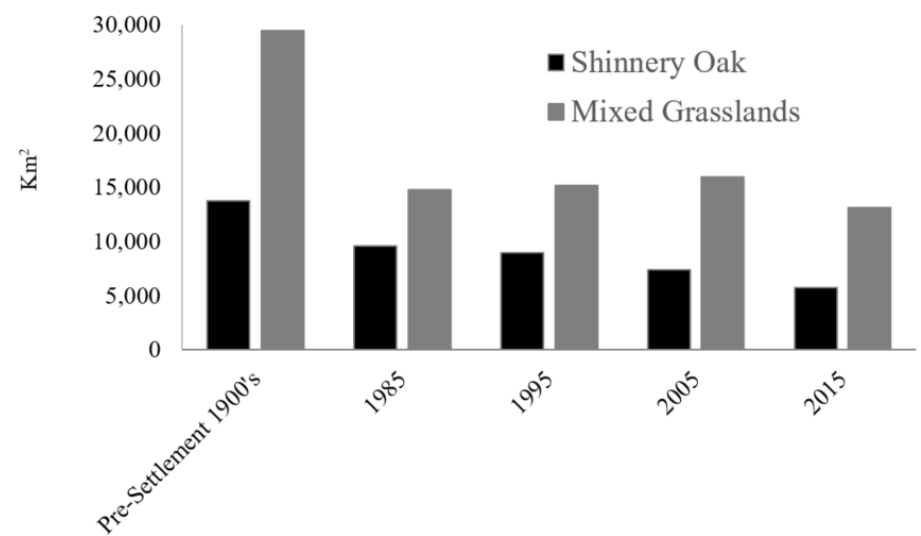
Figure 6. Changes in extent (km 2 ) from historic pre-settlement conditions to 2015 for potential lesser prairie-chicken habitat in the Sand Shinnery Oak Ecoregion on the New Mexico and Texas Southern High Plains, as estimated from historical map survey and Landsat-based image classifications.